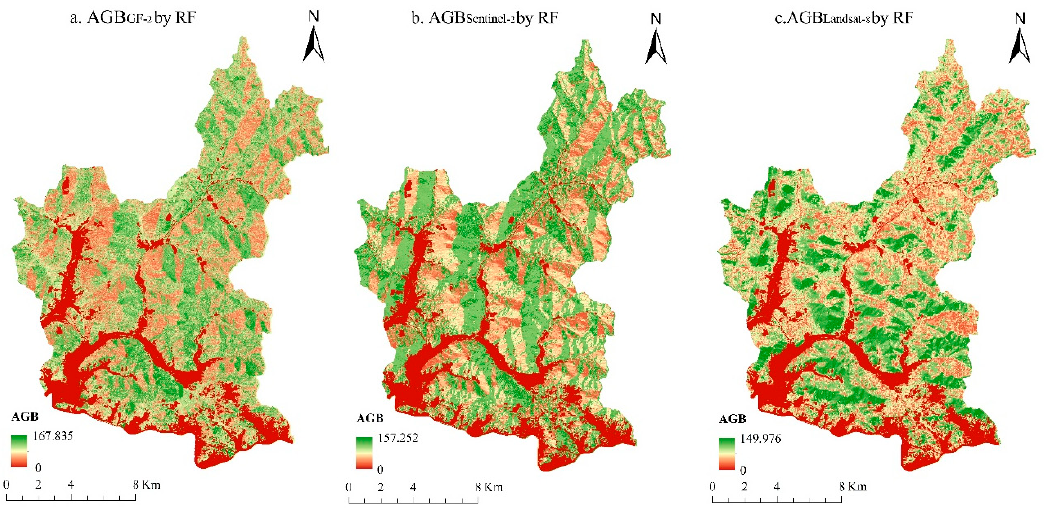
Figure 5. AGB estimation using the random forest model for various remote sensing data: ( a ) AGB estimation result using GF-2; ( b ) AGB estimation result using Sentinel-2; ( c ) AGB estimation result using Landsat-8. (Unit was t/ha).